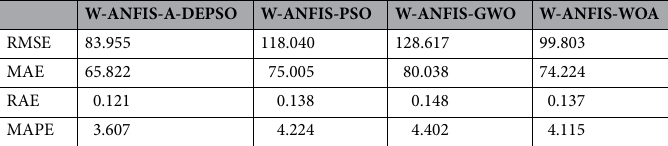
Table 13. Compare W-ANFIS-A-DEPSO with three hybrid models in training stage.